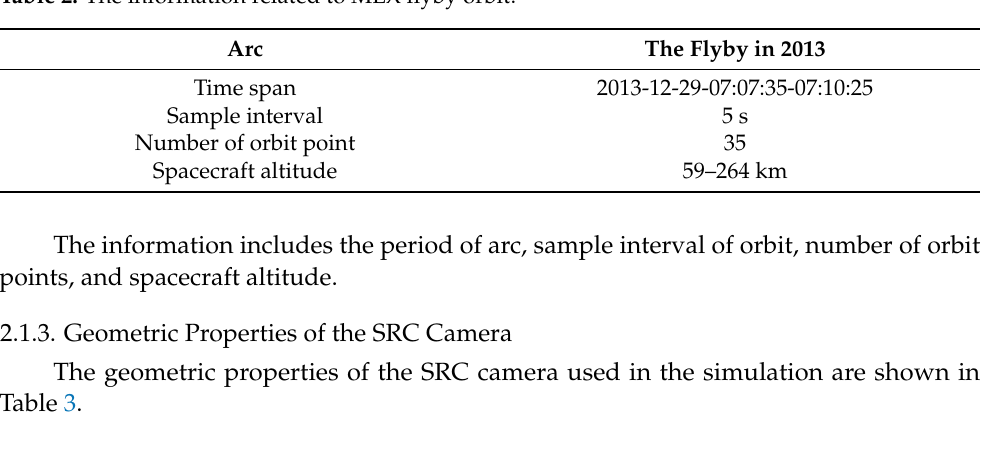
Table 2. The information related to MEX flyby